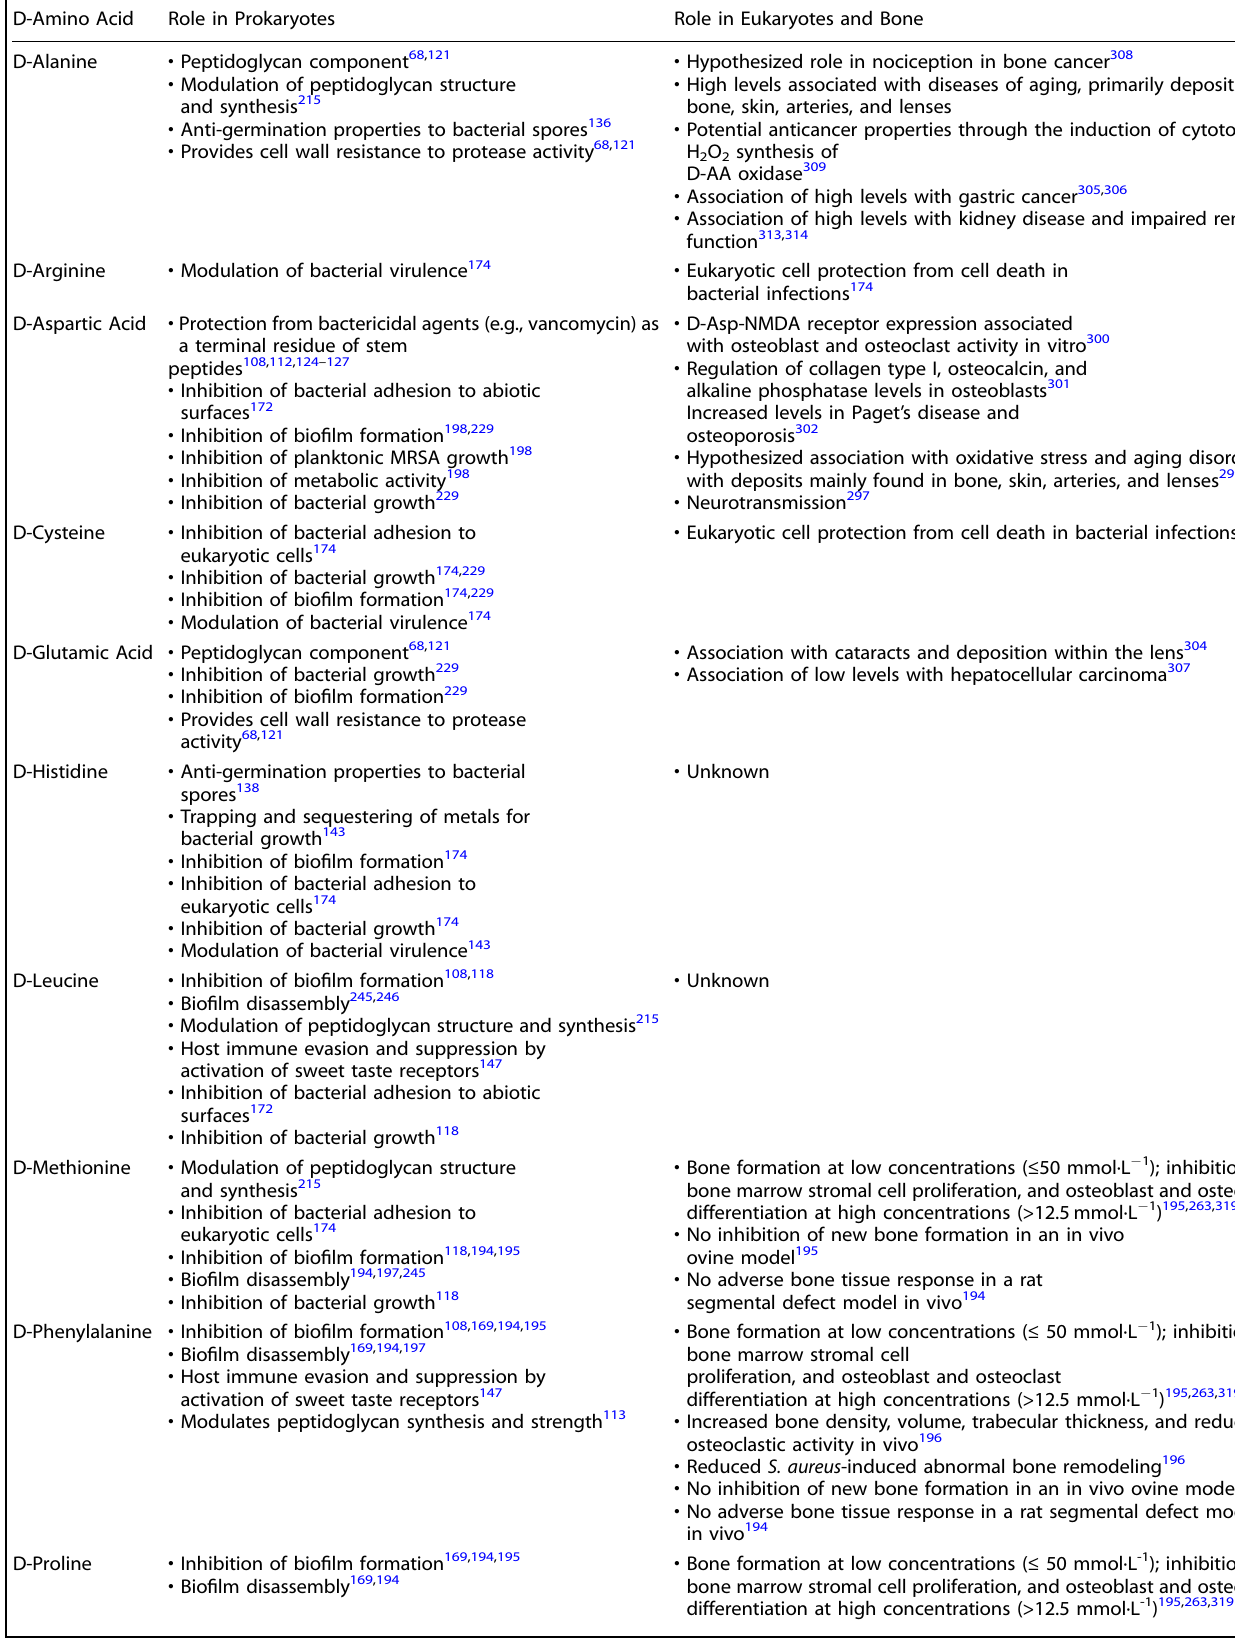
Table 2. A comparative table displaying the differing roles of D-AAs in prokaryotes versus eukaryotes, with a focus on their role in bone tissue D-Amino Acid Role in Prokaryotes Role in Eukaryotes and